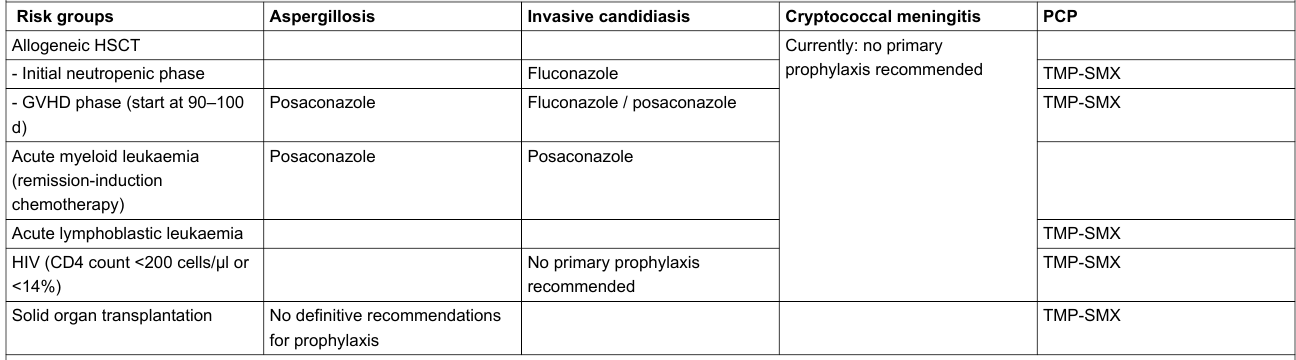
Table 1: Prophylactic regimen with grade A1 and A2 recommendations for invasive candidiasis, aspergillosis, cryptococcal meningitis and Pneumocystis jirovecii pneumonia (PCP). Risk